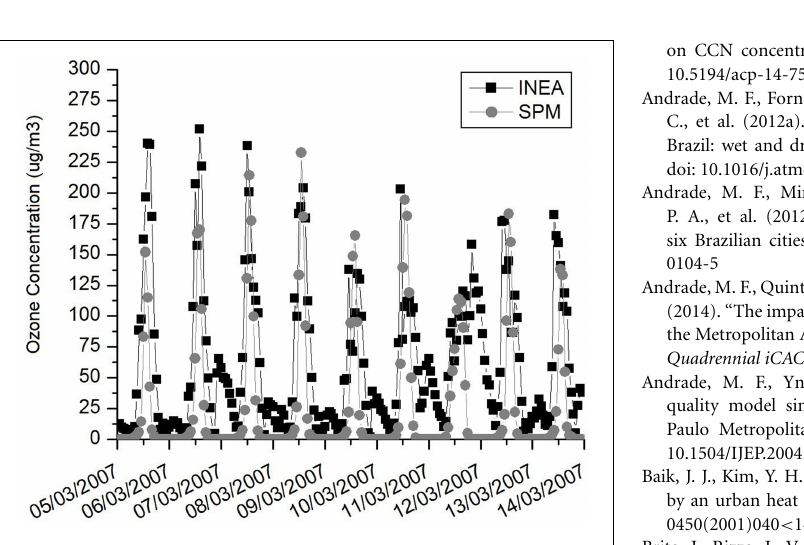
FIGURE 13 | BRAMS-SPM-simulated values for ozone over two sites in the Metropolitan Area of Rio de Janeiro between March 5 and March 14 2007. Sources: Rio de Janeiro Instituto Estadual do Ambiente (INEA), State Environmental Agency; Carvalho